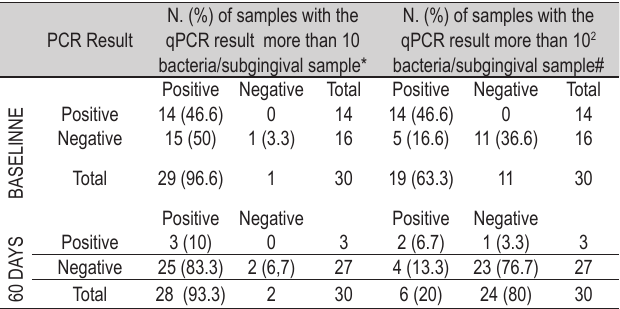
Table 1 - Comparison between PCR and qPCR for the detection of P. gingivalis .